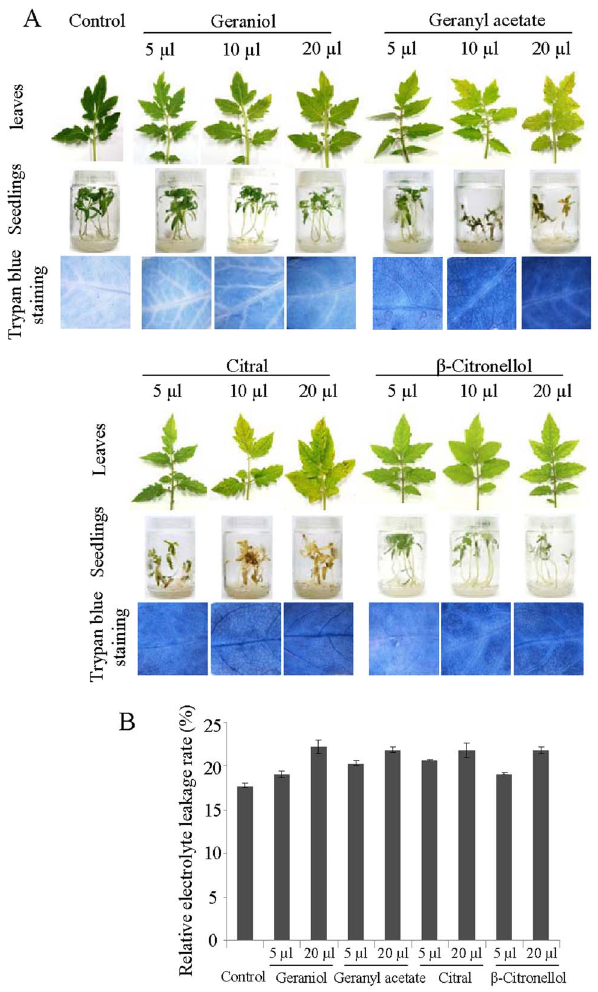
Figure 2. Monoterpene-induced physiological changes in tomato. (A) Development of necrosis in leaves of 45-days old tomato plants and 15-days old tomato seedlings-treated with monoterpene volatiles geraniol, geranyl acetate, citral and b -citronellol. Photographs were taken at 48 and 72 hr after volatile treatments to tomato seedlings and plants, respectively. Trypan blue staining of the leaves, taken from 48 hr monoterpene volatile-treated plants, was carried out to determine the extent of cell death. (B) The electrolyte leakage rate from the leaves was measured at 12 hr after treatment of tomato plants with monoterpene volatiles. Data are mean 6 SEM (n=3).